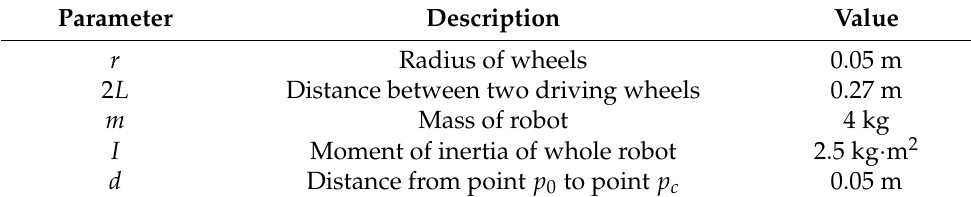
Figure 6. Lemniscate curve trajectory tracking with white noise: ( a ) linear velocity v (m/s) and ( b ) angular velocity ω (rad/s). Table 1. System parameters.